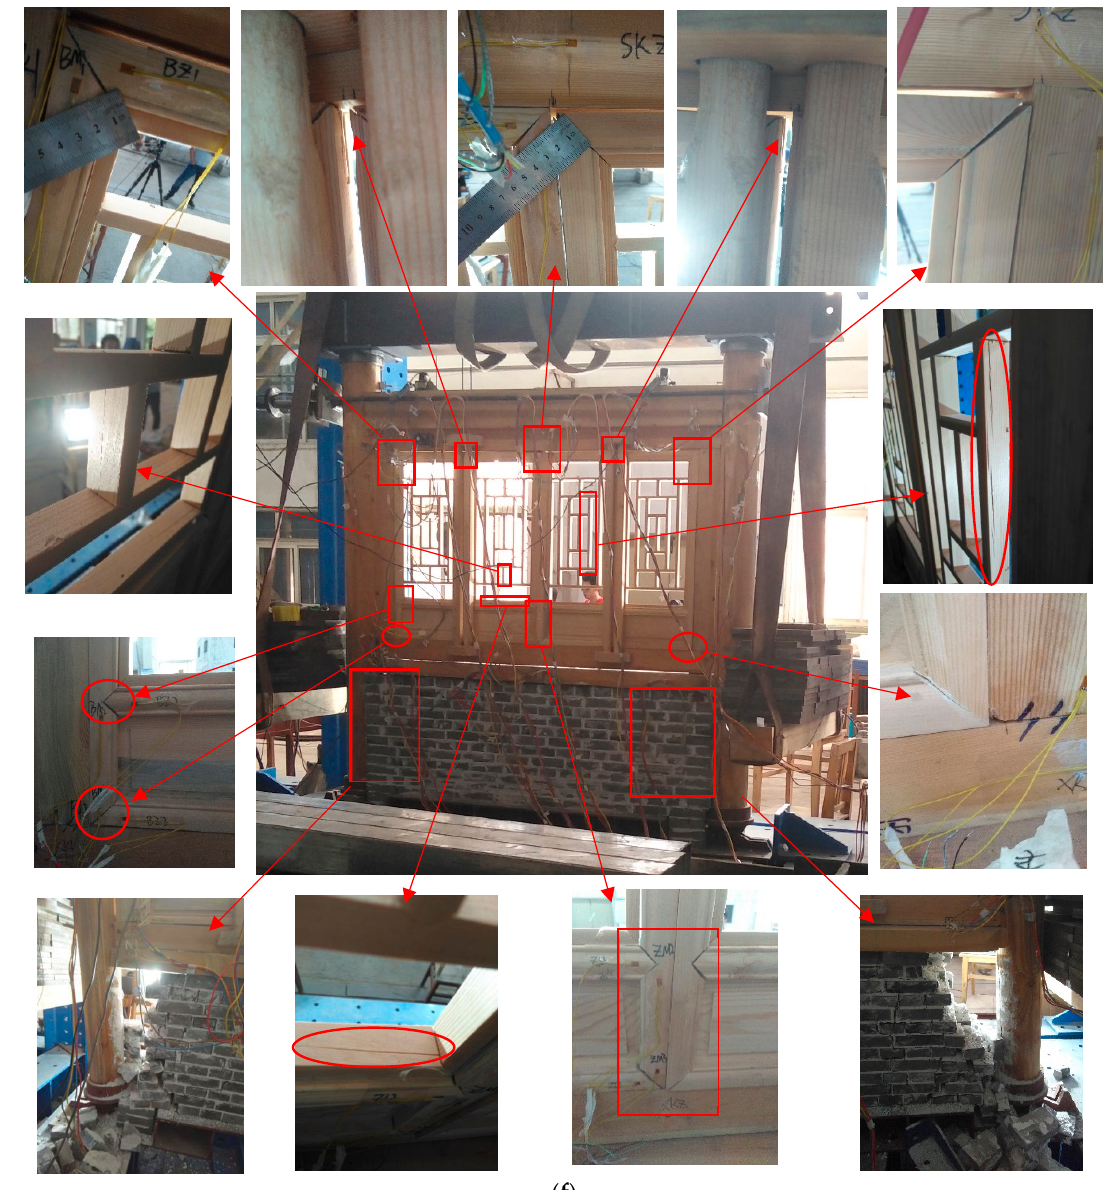
Figure 11. Failure modes of the specimens: ( a ) crack on the left side of masonry wall at a displacement of 10 mm (the drift angle was 1/160); ( b ) penetrating cracks on the right side of the masonry wall at a displacement of 35 mm (the drift angle was 7/320); ( c ) the tenons pull out of mortise at a displacement of 15 mm (the drift angle was 3/320); ( d ) the tenons pull out of the mortise at a displacement of 30 mm (the drift angle was 7/320); ( e ) cracks on the masonry wall at a displacement of 50 mm (the drift angle was 1/32); ( f ) failure modes of the specimens at a displacement of 150 mm (the drift angle was 3/32).